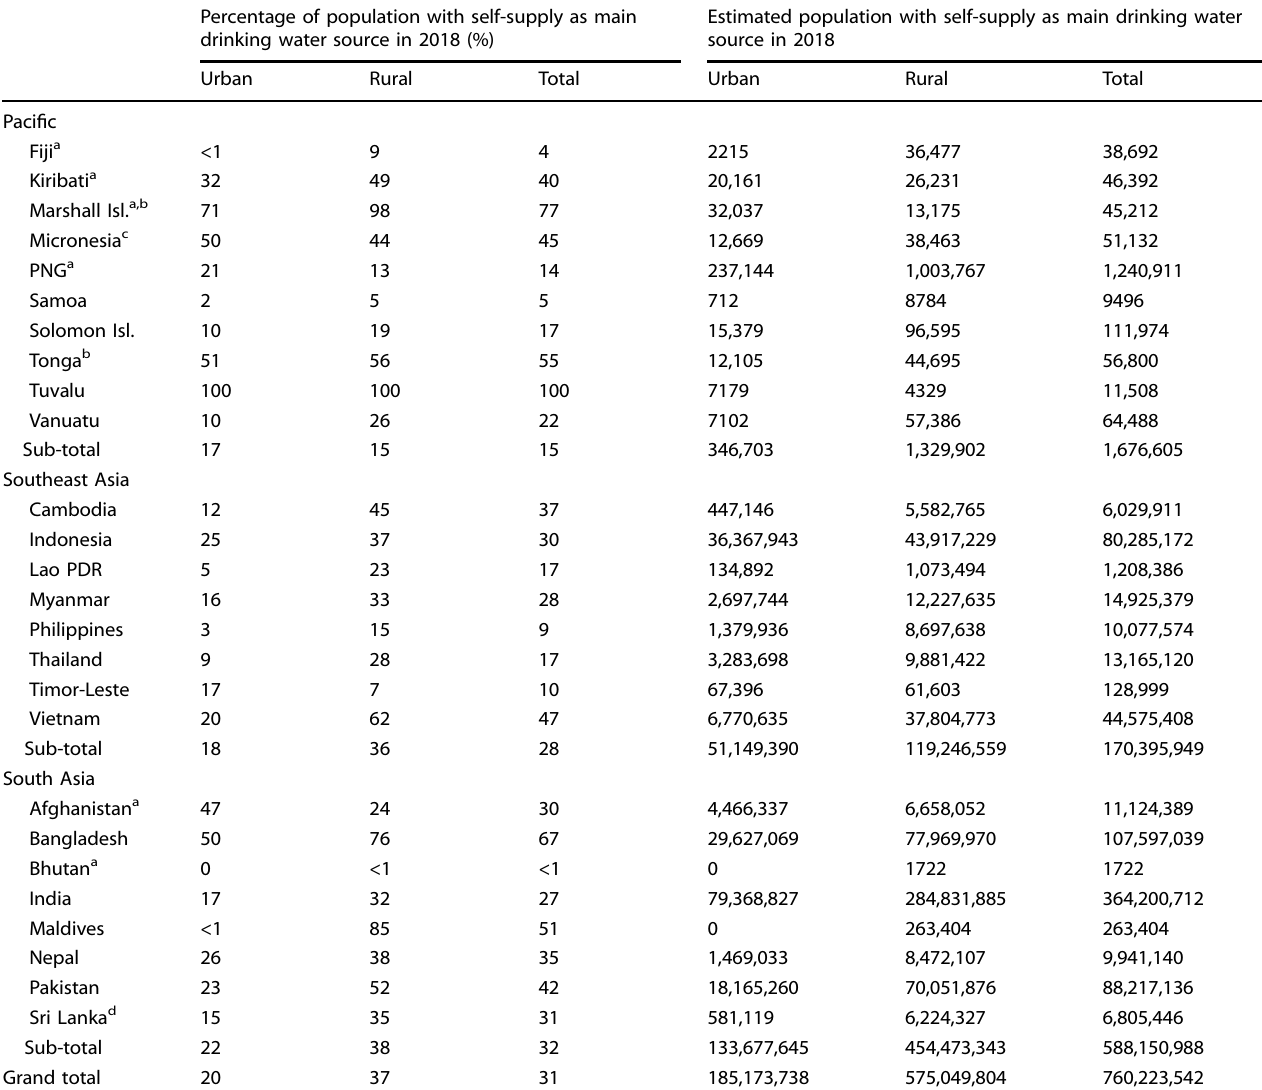
Table 2. Adjusted estimates for population using self-supply as a main drinking water source in 2018 (factoring in temporal